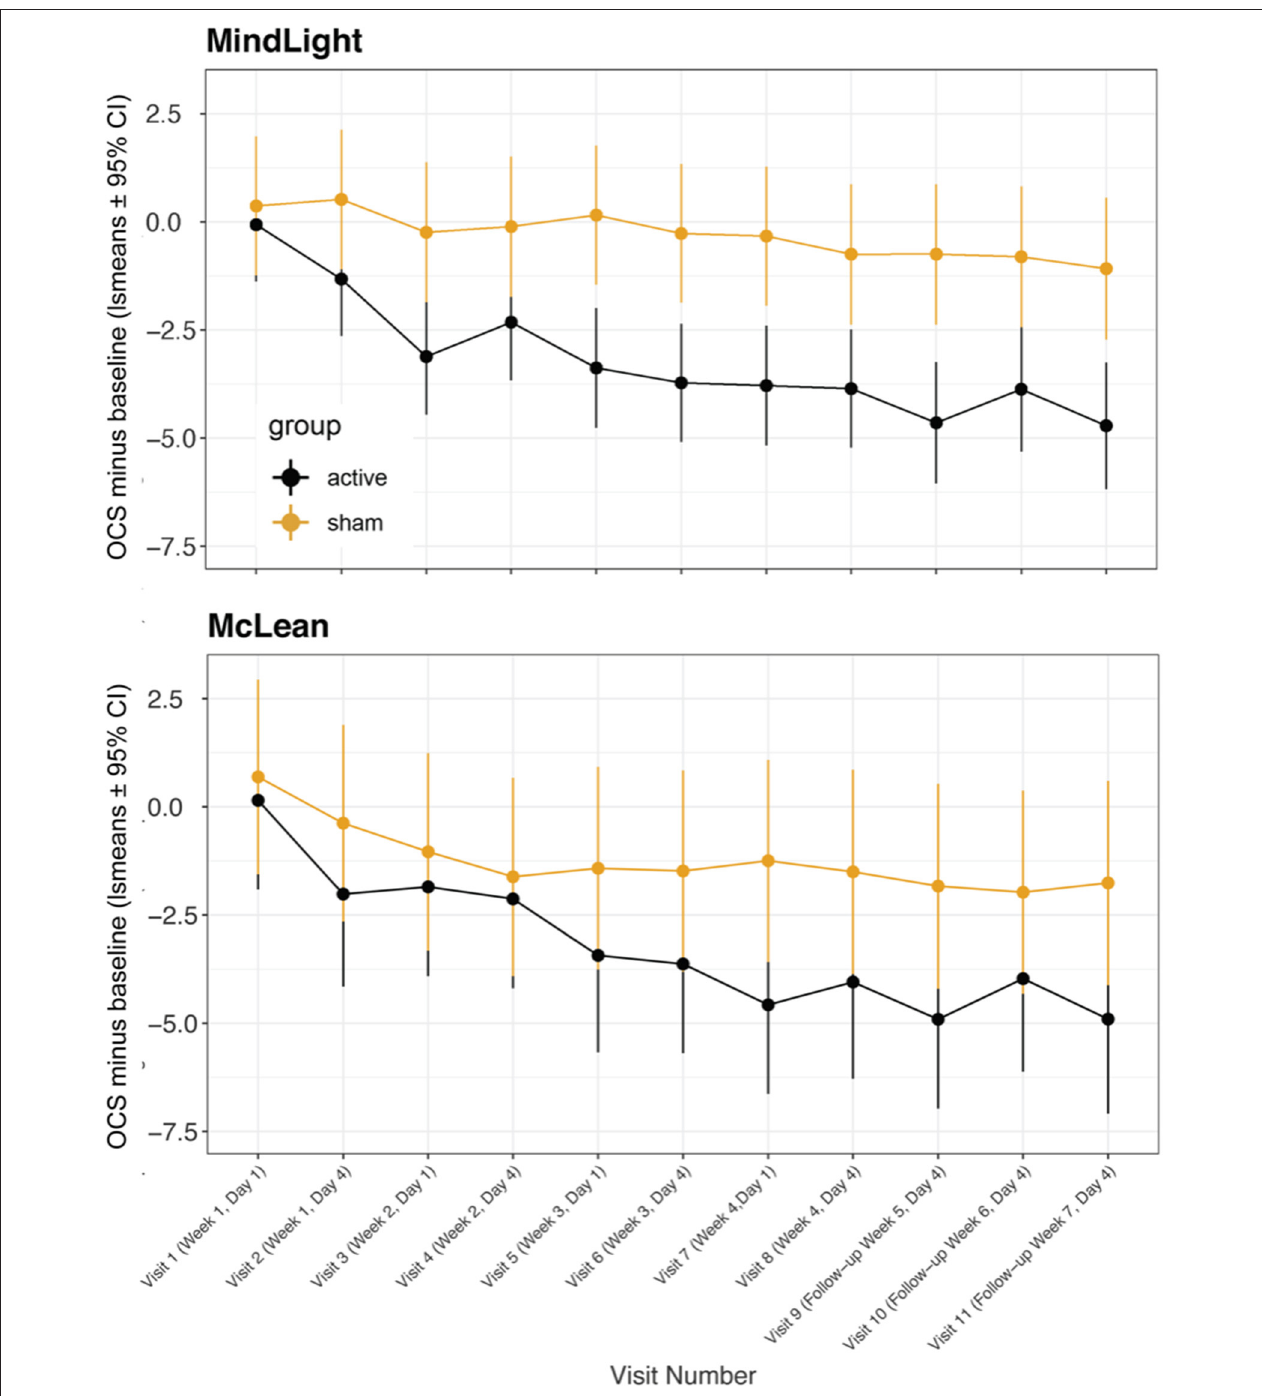
FIGURE 3 | Least square means for opioid craving scores minus baseline from mixed model comparing active vs. sham treatments across visits at MindLight site vs. McLean site. Data are means ± 95% confidence intervals. Overall, there were no significant differences between sites or significant site by visit or treatment